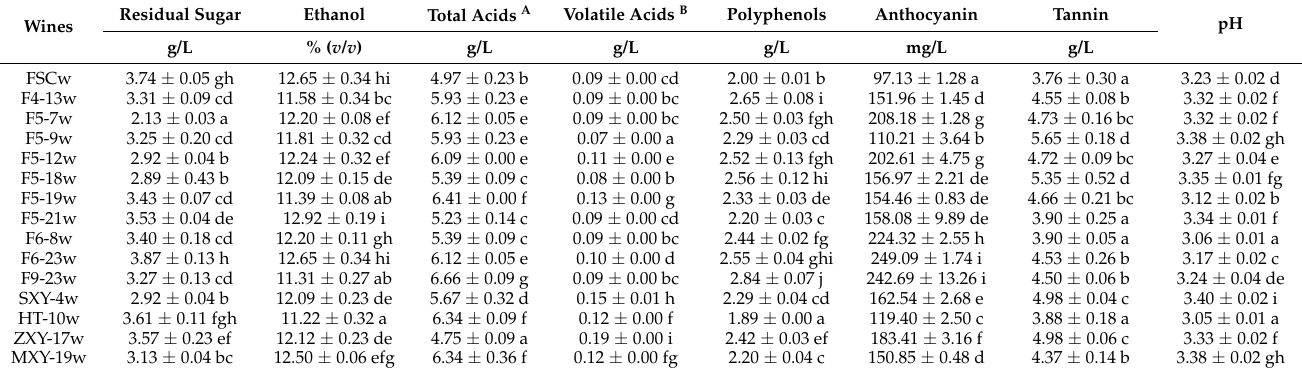
Table 1. Physicochemical compositions of wines fermented by the selected S. cerevisiae